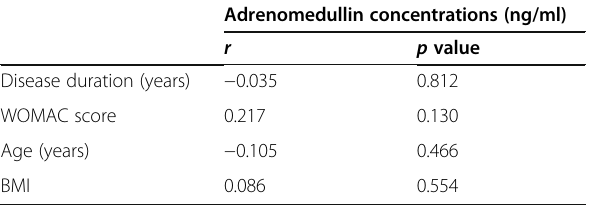
Table 2 Spearman correlation between serum Adrenomedullin concentrations and other parameters of the studied OA cases